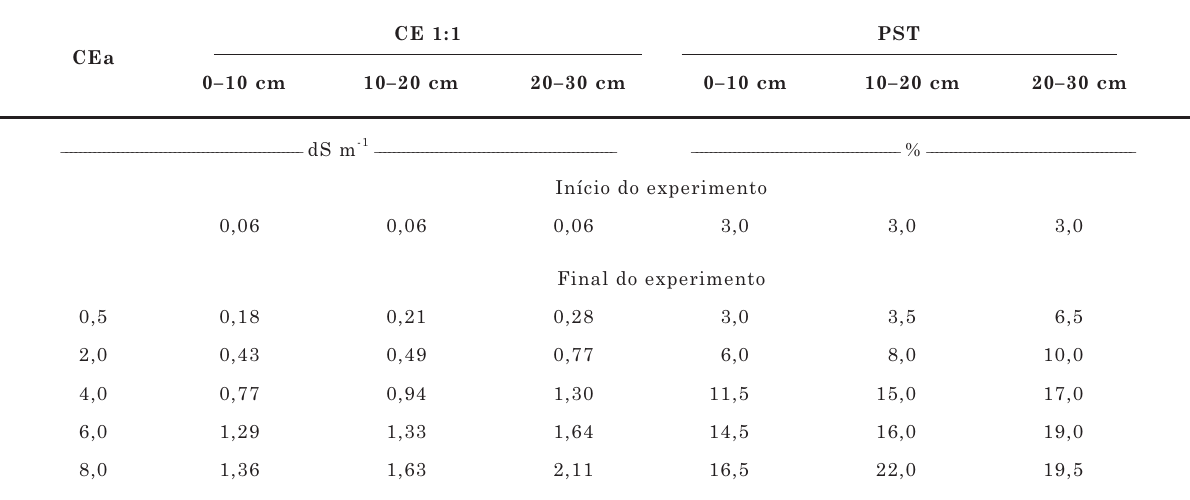
Quadro 1. Valores de condutividade elétrica (CE) em extrato 1:1 (solo:água) e da percentagem de sódio trocável (PST) como variável da condutividade elétrica da água de irrigação (CEa) em diferentes profundidades do solo